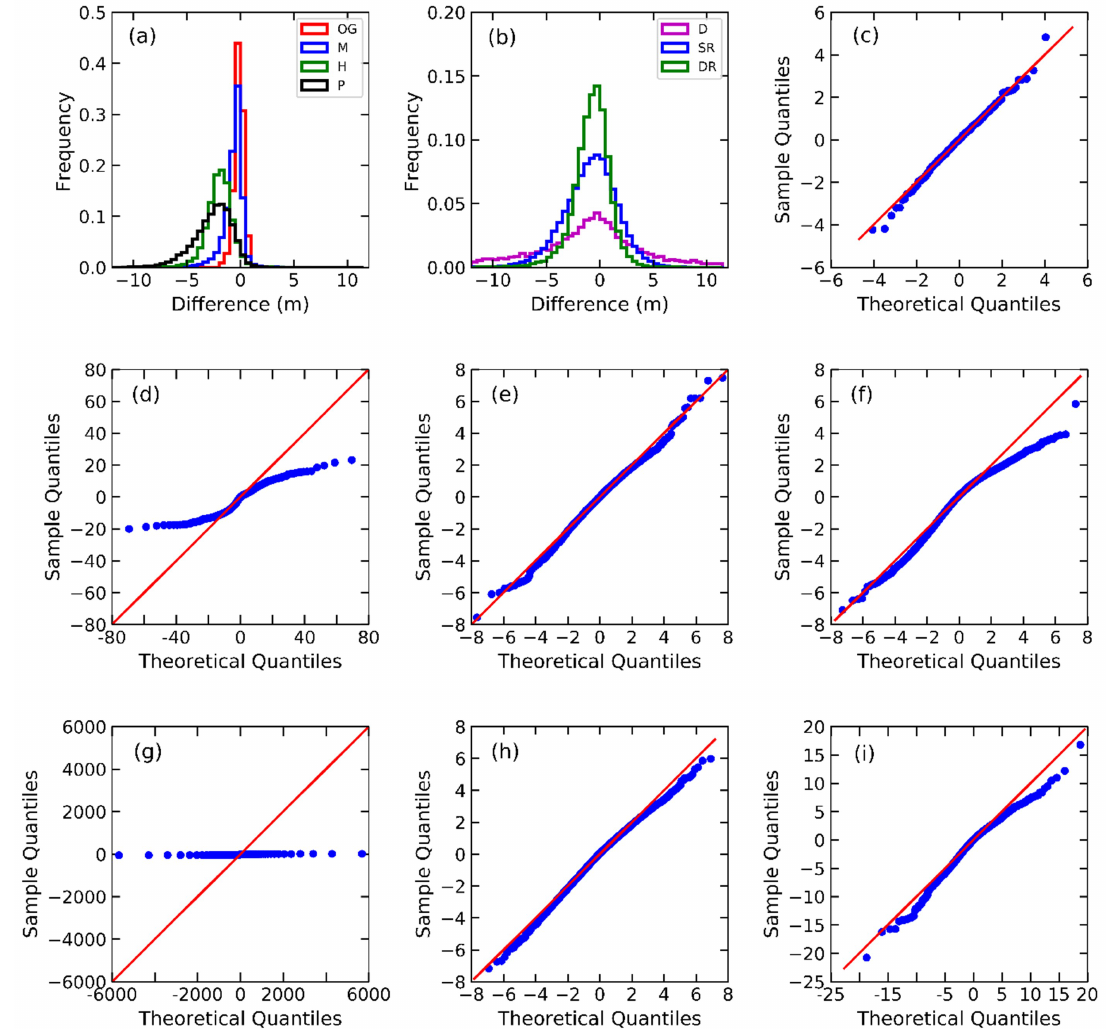
Figure 7. ( a ) Histogram of elevation di ff erences between TDX DEM and LiDAR DSM in open ground (OG) and mangrove (M), hammock (H), and pine (P) forest areas. ( b ) Histogram of elevation di ff erences between TDX DEM and LiDAR DSM in downtown (D), sparse residential (SR), and dense residential (DR) areas. Q-Q plots for open ground ( c ), mangrove forest ( d ), hammock forest ( e ), and pine forest ( f ), downtown ( g ), sparse residential ( h ), and dense residential ( i )